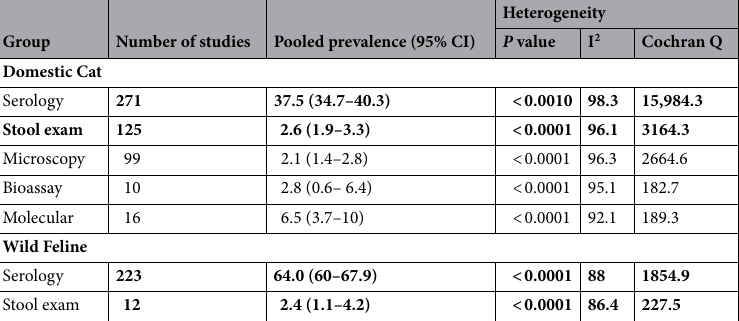
Table 3. The global pooled prevalence of Toxoplasma infection in feline hosts/felids.